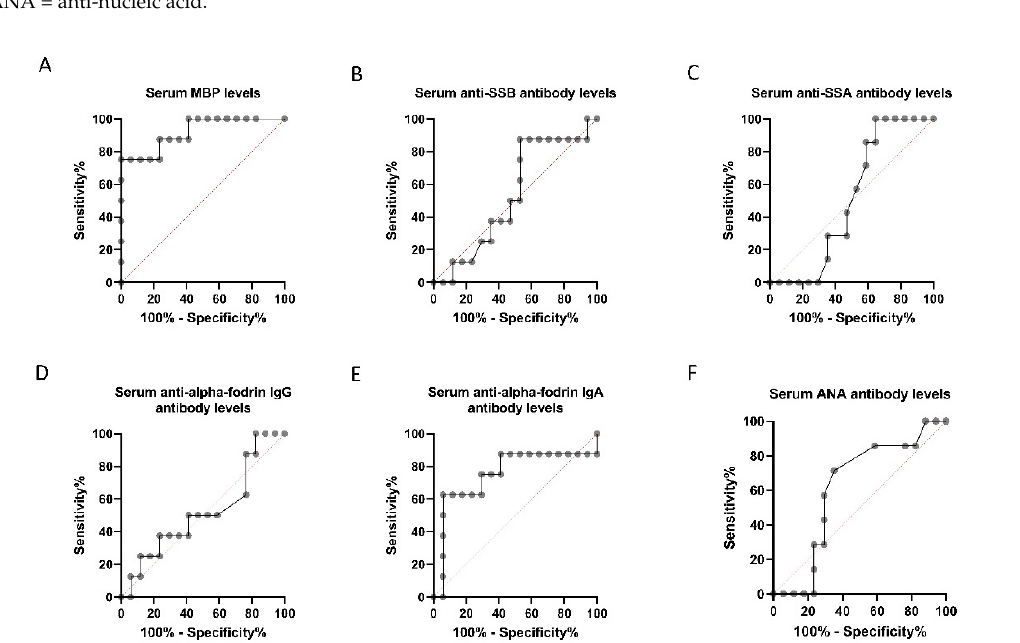
antigen B; ANA = anti-nucleic acid.